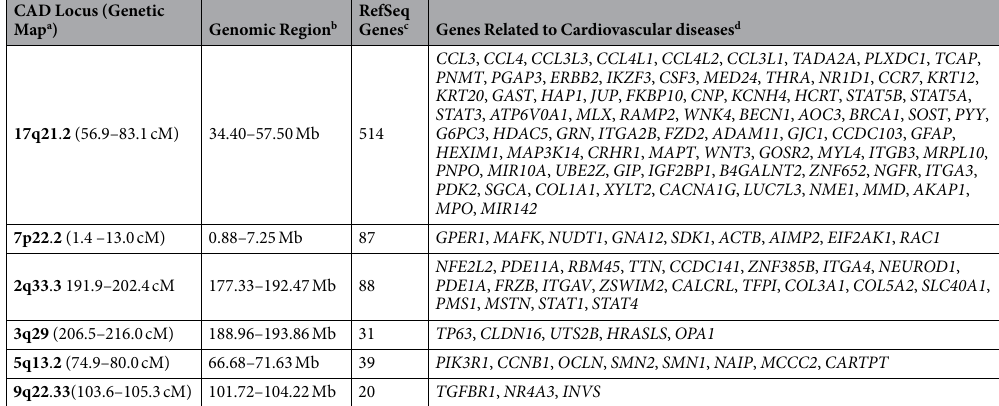
Table 5. Summary of RefSeq Genes Related to Cardiovascaulre Diseases Under Each Linkage for CAD in the Combined GenQuest II Families. a Genetic map based on the Marshfield Medical Genetics database (http:// research.marshfieldclinic.org/genetics/GeneticResearch/screeningsets.asp). b Physical map based on hg19 by Adam Auton in 1000 Genome project (https://github.com/joepickrell/1000-genomes-genetic-maps). c ReSeq genes retreived from the UCSC RefSeq database (Track: RefSeq Genes; assembly: GRCH37/hg19). d Related genes were explored using program DisGeNet. Any gene-disease pair with a score of > 0.001 was defined as a valid